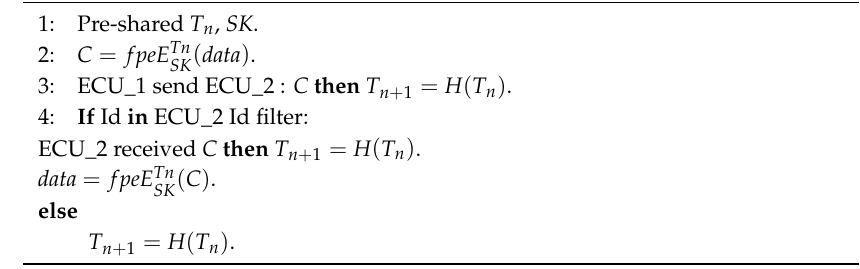
Algorithm 2 Controller area network (CAN) data field encryption / decryption